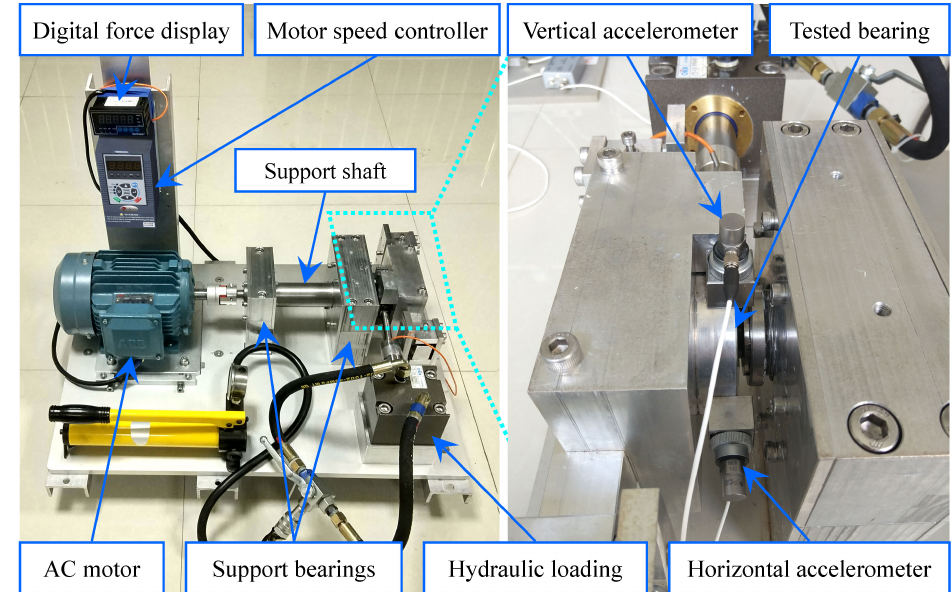
Figure 8. XJTU-SY bearing accelerated degradation testbed [32].